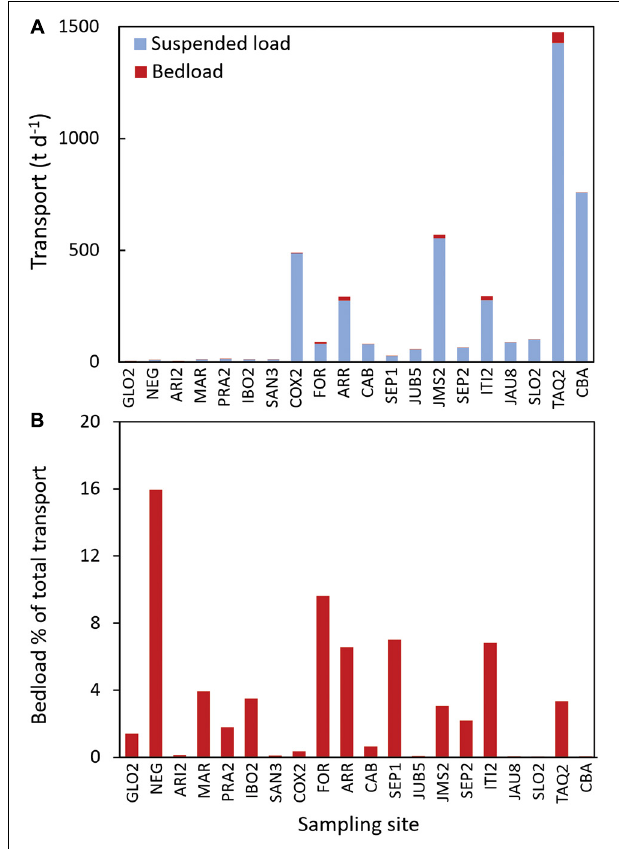
Table S3 . The changes between upstream and downstream are presented as both concentrations, which bear on the nutrient availability and aquatic ecology of downstream waters, and rates of transport (i.e., t d − 1 ), which bear on the overall sediment supply from the upland watersheds to the Pantanal. For a given hydropower facility, the ratios between concentrations and transport covary because we assumed that discharge did not change and therefore